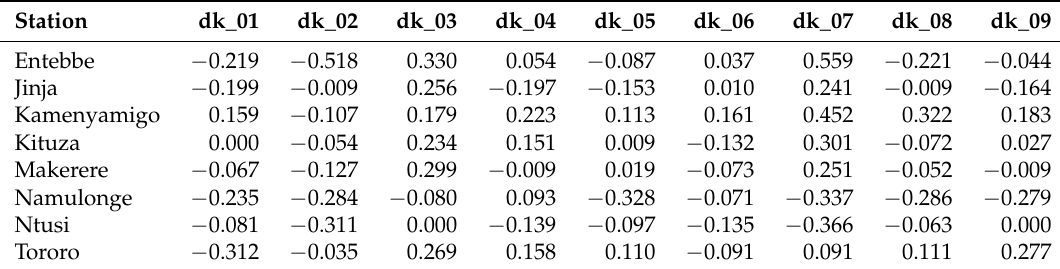
Table 4. MK results for the dekadal trend of rain